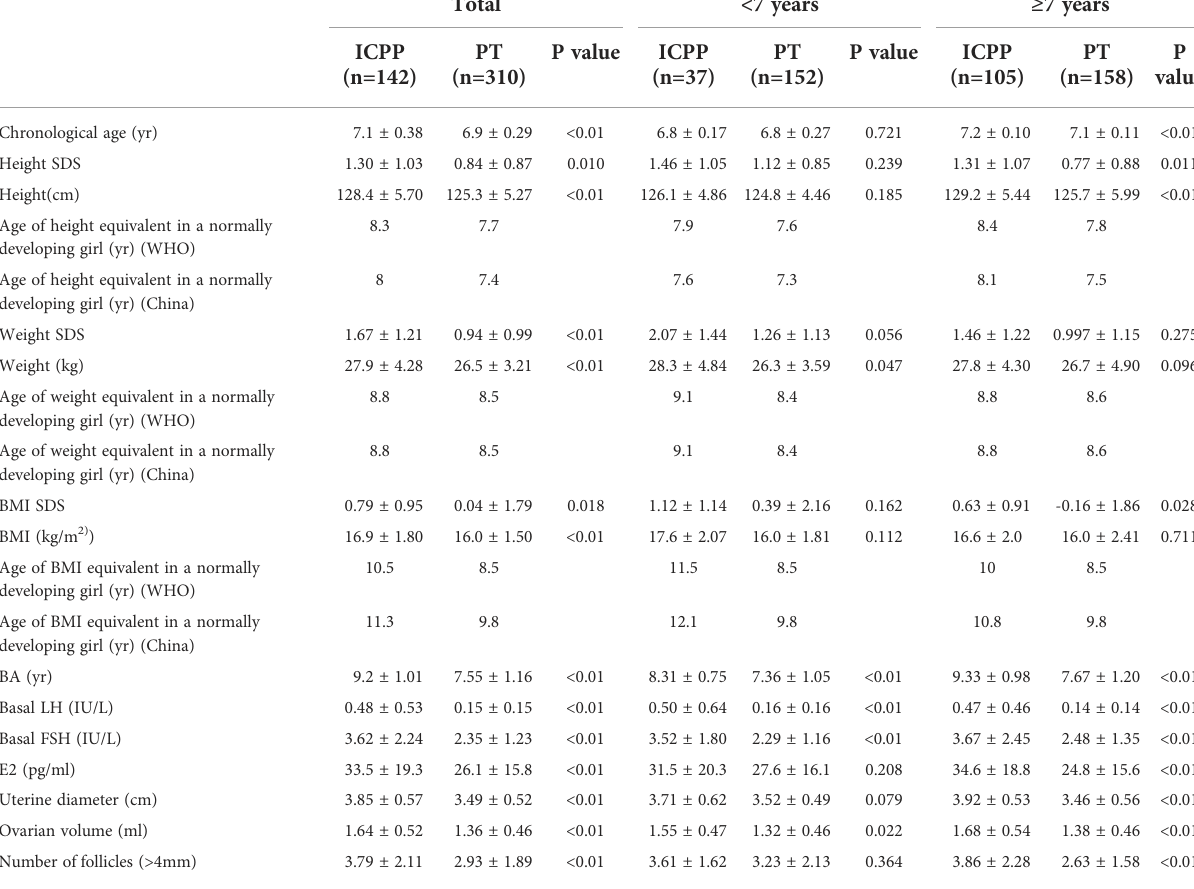
TABLE 2 Physical and sexual development at the initial visit in the ICPP and PT